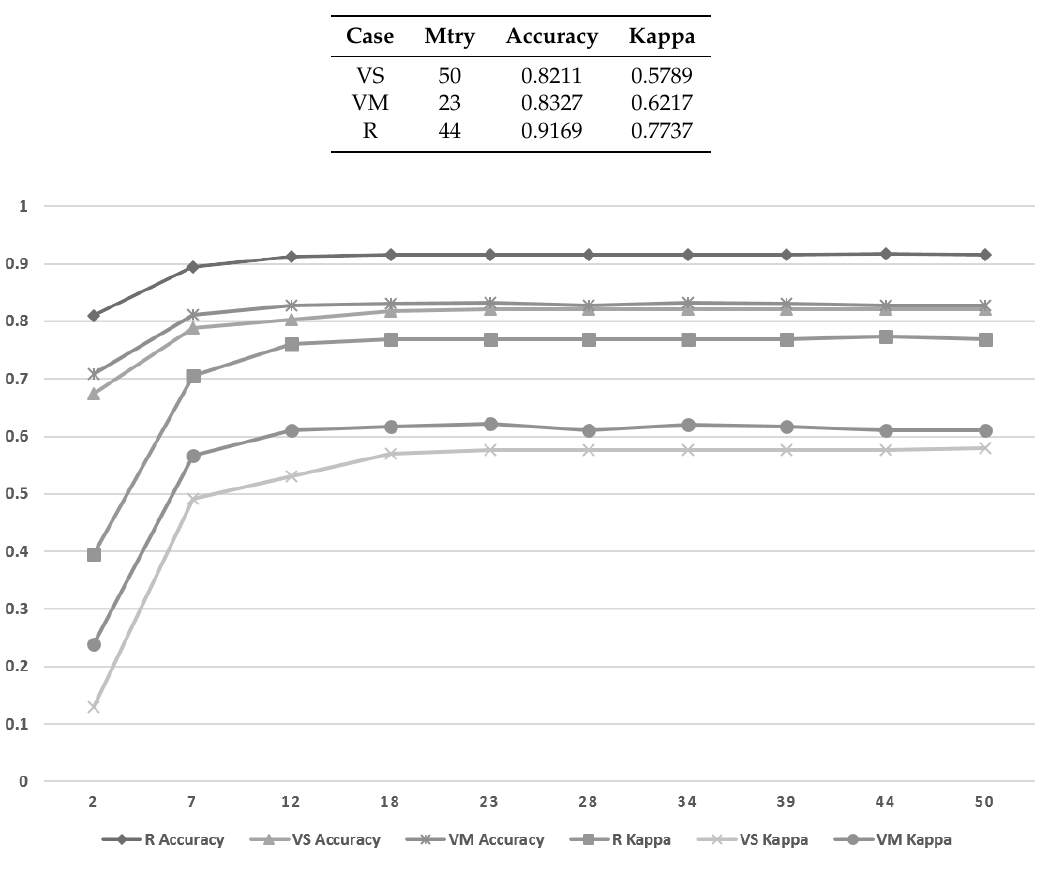
Figure 4. Graph of adjustment of the results of the mtry